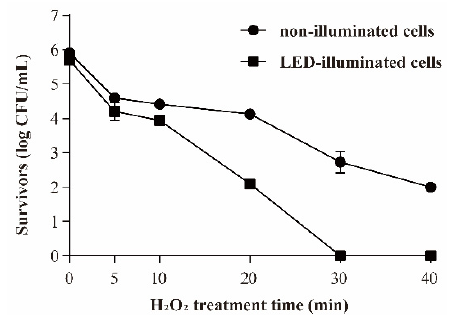
Figure 5. Survival of S . Typhimurium in 0.01% H 2 O 2 . ( ● ) non-illuminated cells, ( ■ ) 405 nm LED- illuminated cells.